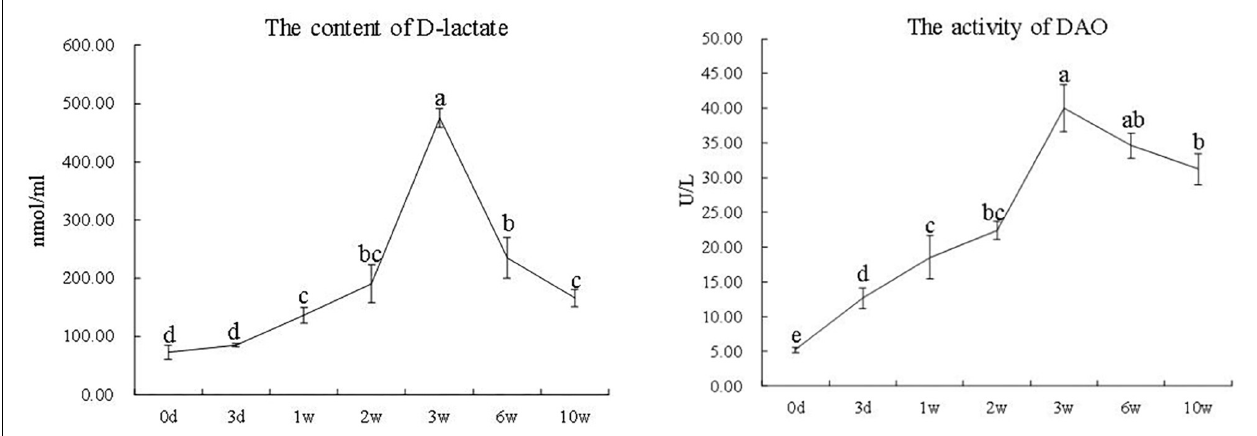
FIGURE 3 | The activity of DAO and the content of D -lactate in serum at different time points in the 7S&FM group. Results are expressed as means ± standard error. Different letters above the broken lines denote significant ( P < 0.05) differences at different time